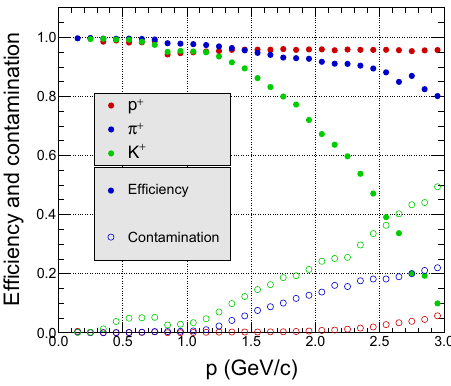
Figure 5: PID e ffi ciency and contamination